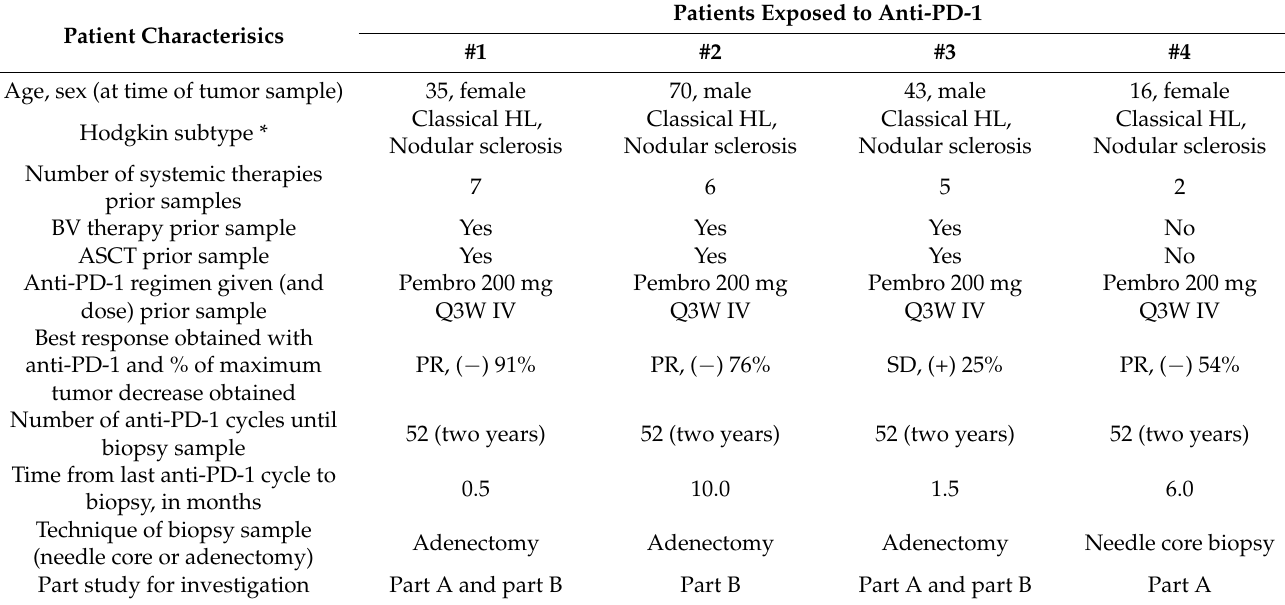
Table 1. Main clinical characteristics of patients exposed to anti-PD-1 with classical Hodgkin lymphoma included in the study.